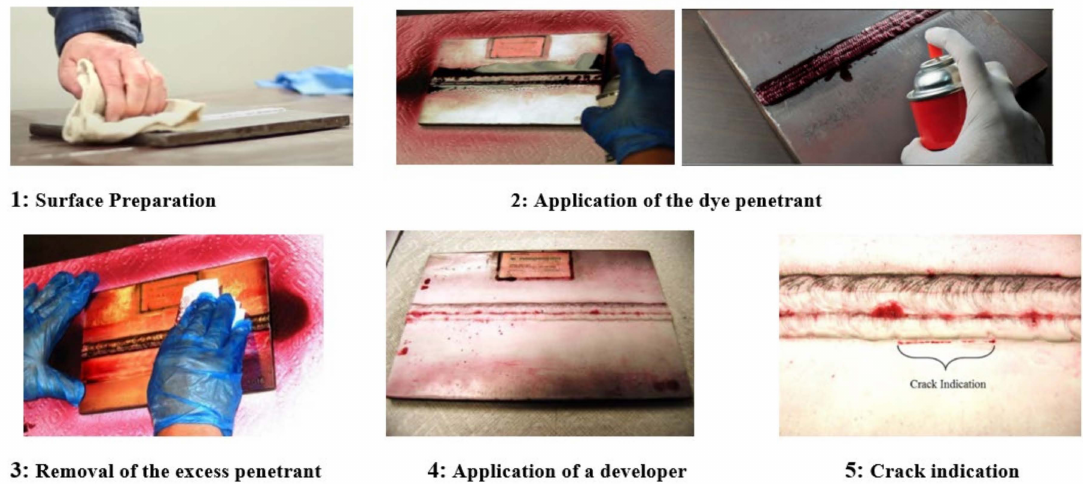
Figure 4. Steps for implementation of PT tests [13].